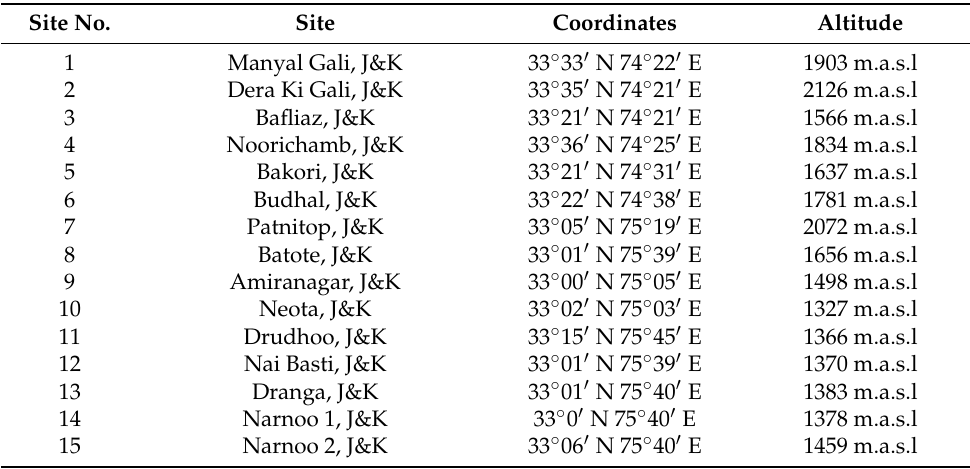
Table 1. Geographical coordinates and altitude of different study areas. Site